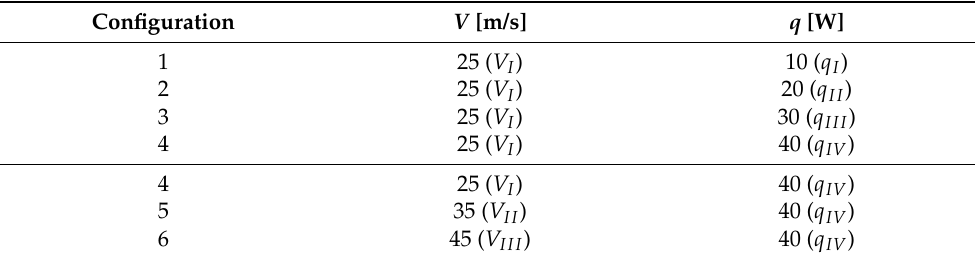
Table 1. System input parameter values for the designed test configurations.